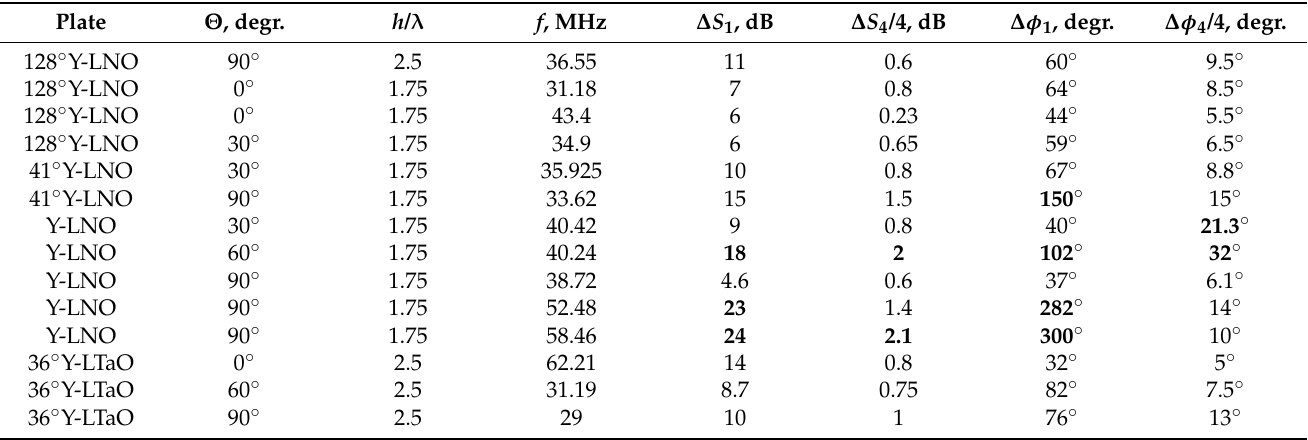
Table 3. Acoustic plate modes with enhanced sensitivity towards liquid conductivity measured for different plates and propagation